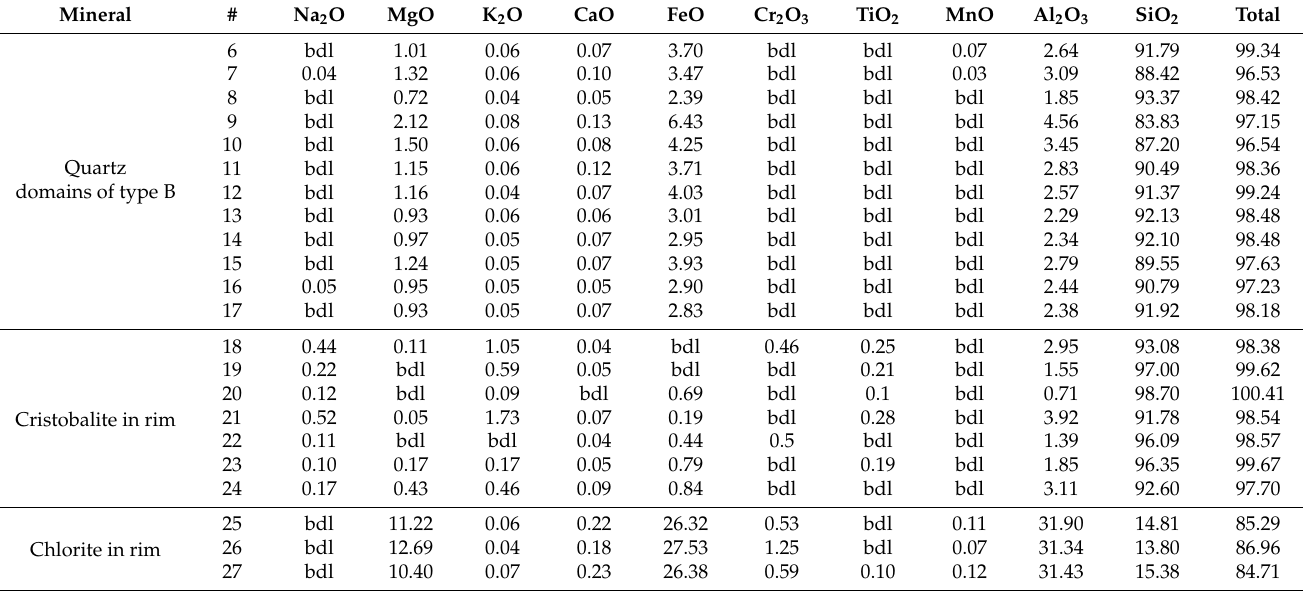
Measured EPMA data, wt.%; bdl = below the detection limit. The serial number corresponds to the point number in Figure 4. Domains A and B could also be distinguished by using panchromatic CL images (Figure 2d). The bright CL response is typical for domains of type A. The color of CL in domains of type A is blueish, and in domains of type B, it is reddish. The CL spectra of the domains of type A consist of wide bands positioned at 252, 353, 426, 491, and 630 nm (Figure 5a). The regions with low CL intensities correspond to domains of type B, where the CL spectra show two peaks at 460 nm and the main one at 647 nm (Figure 5b).